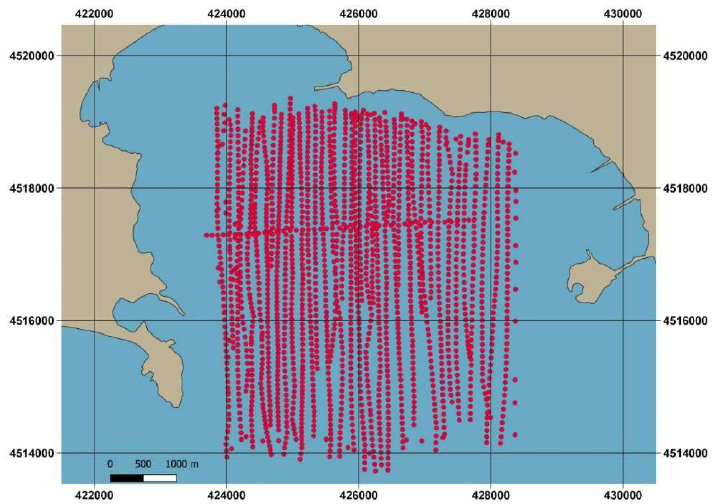
Figure 8. Point cloud dataset concerning the seabed of the Baia of Pozzuoli supplied by IIMM: 2D representation in QGIS.